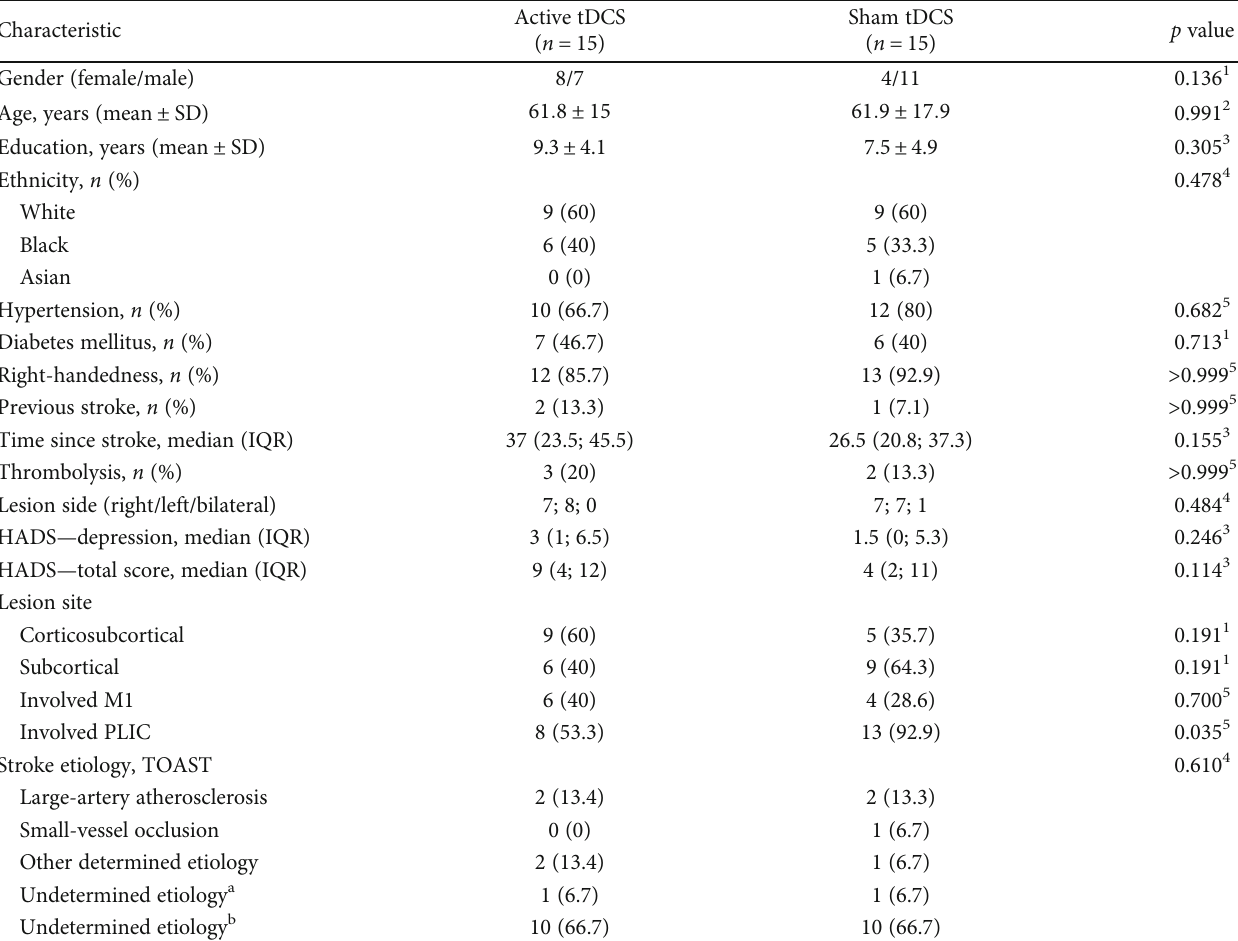
Table 1: Characteristics of the